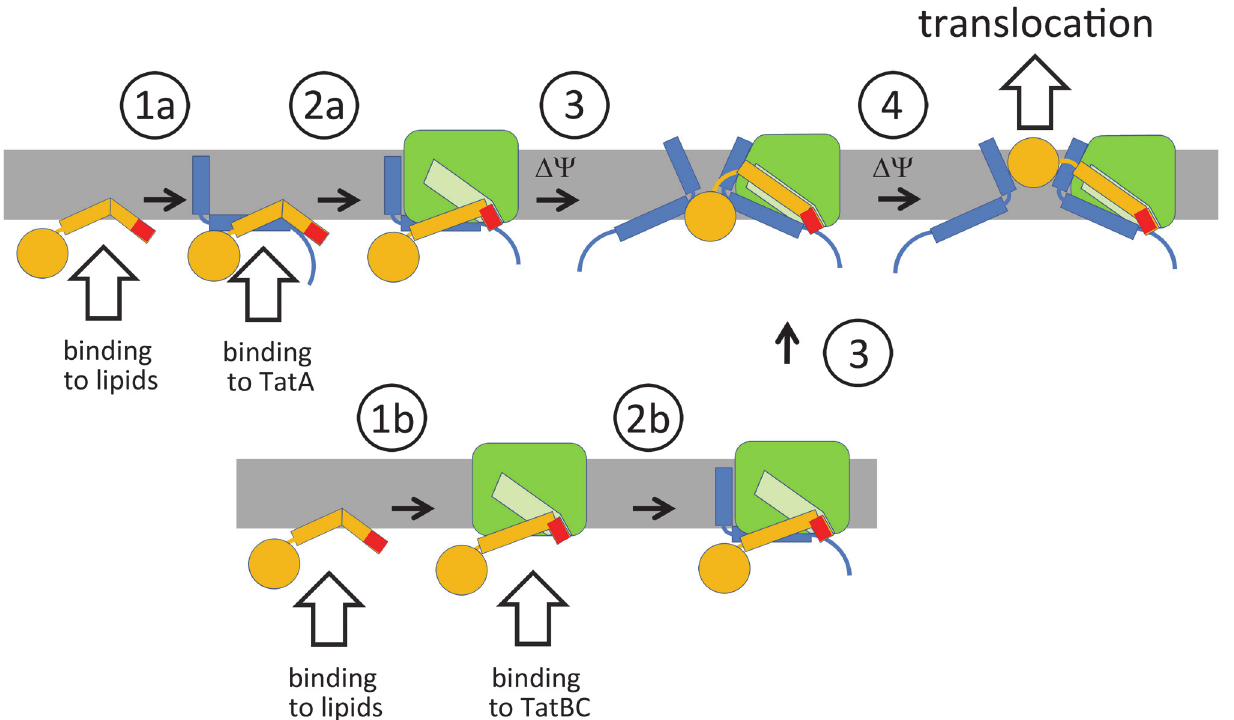
Fig 9. Interactions during Tat translocon assembly. Tat substrate signal peptides such as from HiPIP or NrfC can spontaneously interact with membrane surfaces where they can either encounter free TatA (1a) or TatABC complexes (1b). TatA-bound substrates expose the RR-motif that is recognized by TatBC in the TatABC complex (2a). More TatA is recruited, possibly when TatBC imposes a force to the Tat substrate, which could influence TatA orientations and the local membrane curvature (3). Such a force could result from the known binding of larger signal peptide regions into the membrane-dunking binding-site regions at TatBC. Sufficient TatA recruitment finally permits translocation (4). If Tat substrates are first bound to TatBC, either after membrane interaction or directly (1b), the TatA assembly has to take place thereafter (2b). Such a binding may be more relevant for Tat substrates that do not readily interact with membranes, as the likelihood to first encounter TatA in membranes is high. “ ΔΨ ” designates steps that likely require the membrane potential. Color-code: Tat substrate, yellow; twin-arginine motif, red; TatA, blue; TatBC, green; binding-site for the signal peptide in TatBC, light green.